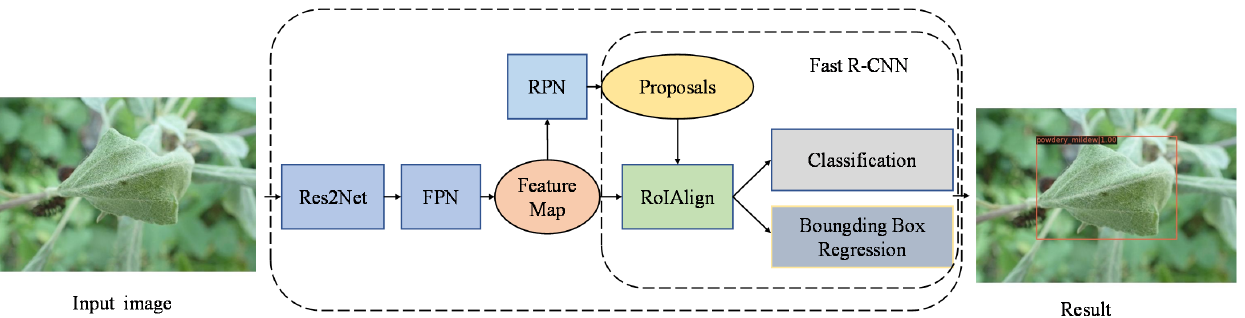
Figure 2. The flowchart of the detection model using Faster R-CNN. (The result picture contains the predicted disease category, the confidence, and the location of the disease marked by an orange